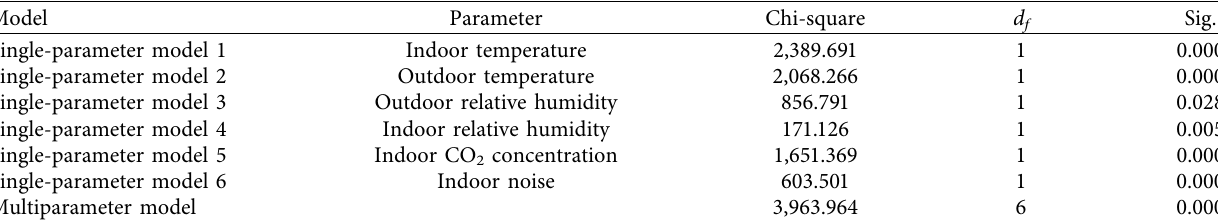
Table 4: Model coefficient test